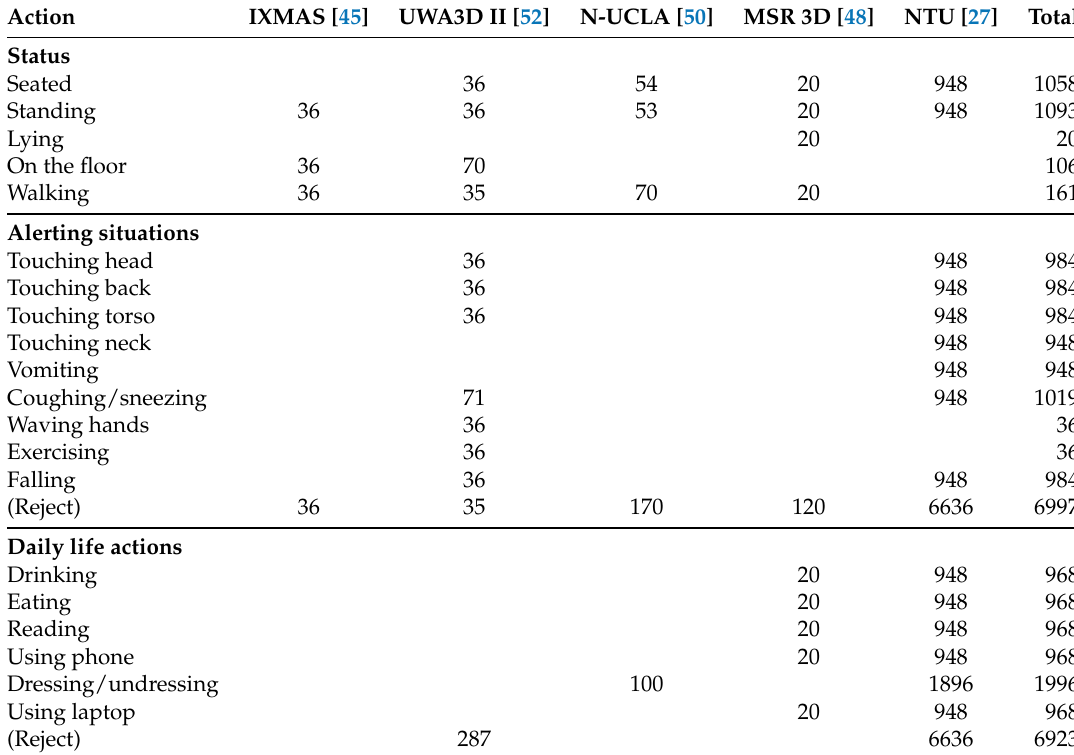
Table 4. Number of samples provided by each dataset that compose the merged